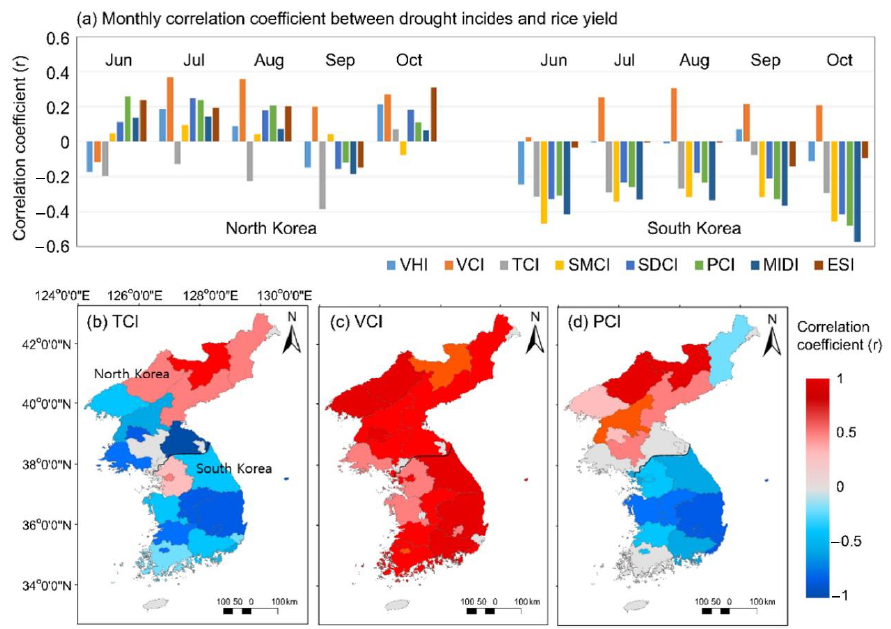
Figure 2. The correlation coefficients (r) between rice yields and each of the drought indices during the growing season over North Korea and South Korea ( a ). The correlation maps of TCI ( b ), VCI ( c ), and PCI ( d ) in July with respect to rice yield.